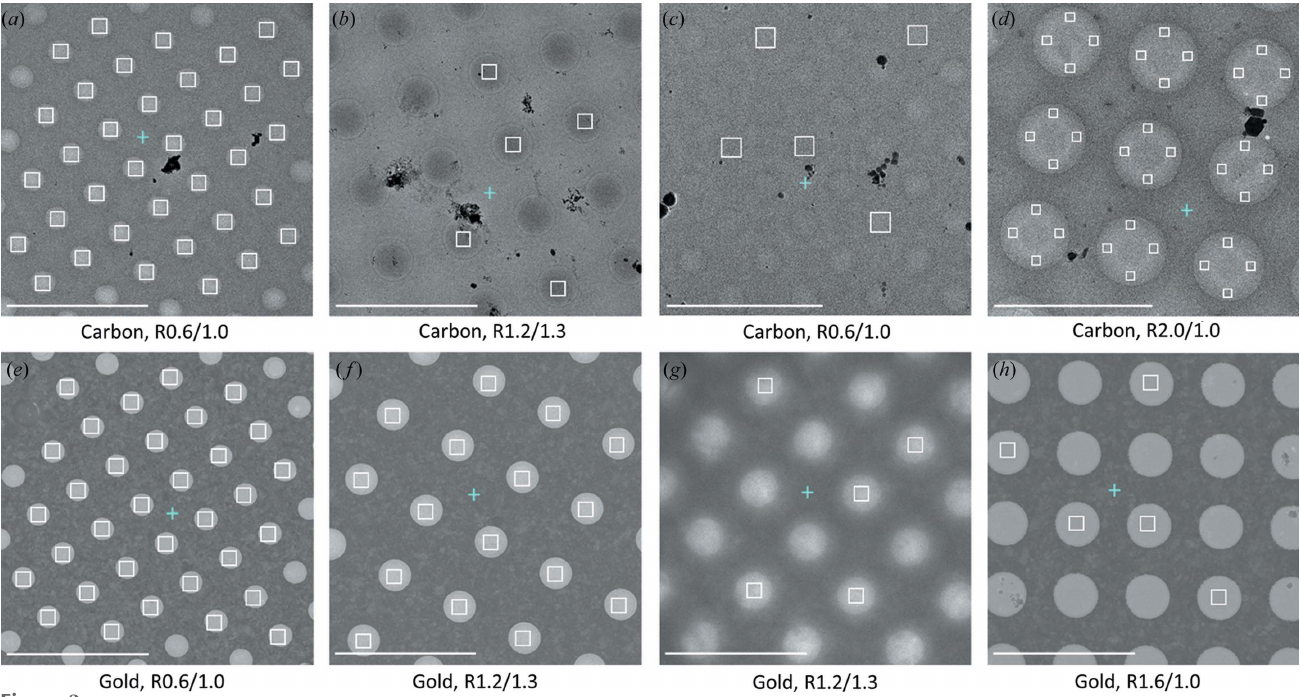
Figure 3 Smart Leginon hole finding using Ptolemy applied to Quantifoil grids of different materials, hole sizes, spacings and characteristics. The top row shows targeting on carbon foil grids and the bottom row on gold foil grids. ( a ) R0.6/1.0 carbon grid with minor contamination and uniform ice where all holes were identified and targeted (white field-of-view boxes). ( b ) R1.2/1.3 carbon grid with moderate contamination where the holes are darker than the surrounding foil, and all holes were identified and a random subset of 5 targeted. ( c ) R0.6/1.0 carbon grid with thick and non-uniform ice and minor contamination where all holes were identified and a random subset of 5 targeted. ( d ) R2.0/1.0 carbon grid with minor contamination where all holes were identified and targeted with 4 multi-shot targets. ( e ) R0.6/1.0 gold grid with minor contamination (top-left hole) where all holes were identified and all non-contaminated holes targeted. ( f ) R1.2/1.3 gold grid with no contamination where all holes were identified and targeted. ( g ) R1.2/1.3 gold grid with thick ice and no contamination where all holes were identified and a random subset of 5 targeted. ( h ) R1.6/1.0 gold grid with minor contamination where all holes were identified and a random subset of 5 targeted. Blue plus signs (+) are automatically determined focus locations. Note: an exclusion border was applied to each image, so some edge holes are not targeted. Scale bars are 5 m